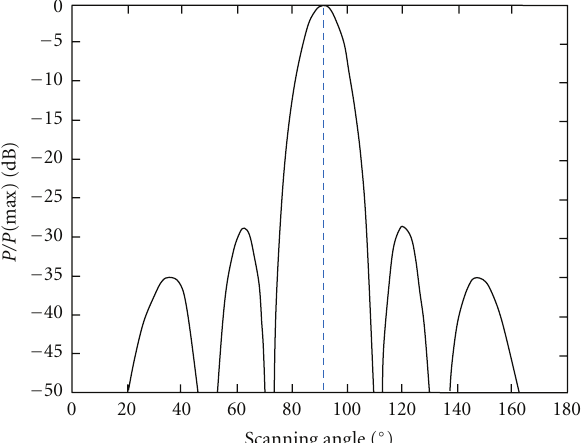
Figure 11: The beam pattern pointed towards the signal-glancing